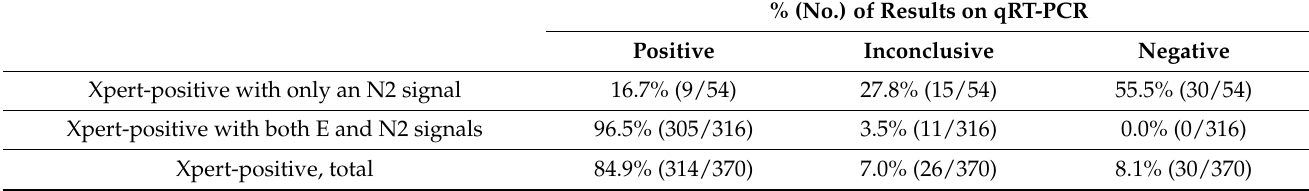
Table 1. Comparative results for the Xpert and qRT-PCR assays conducted using nasopharyngeal swab clinical